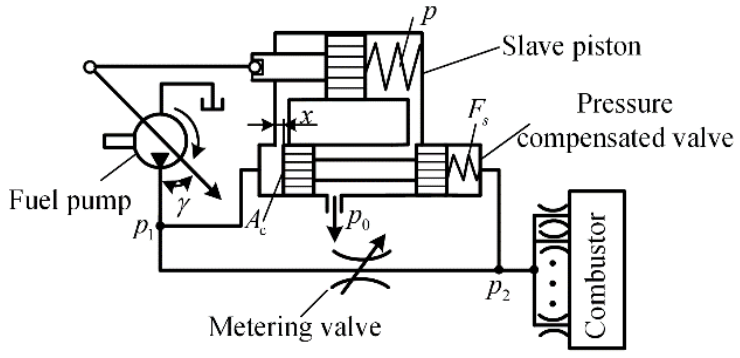
Figure 5. Schematic of pump-based flowrate control system.